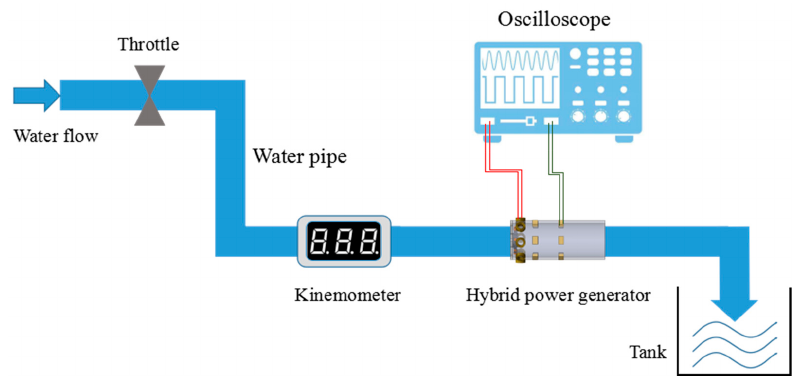
Figure 10. Testing scenario of the collective performance of TEG and EMG. Micromachines 2018 , 9 , x FOR PEER REVIEW